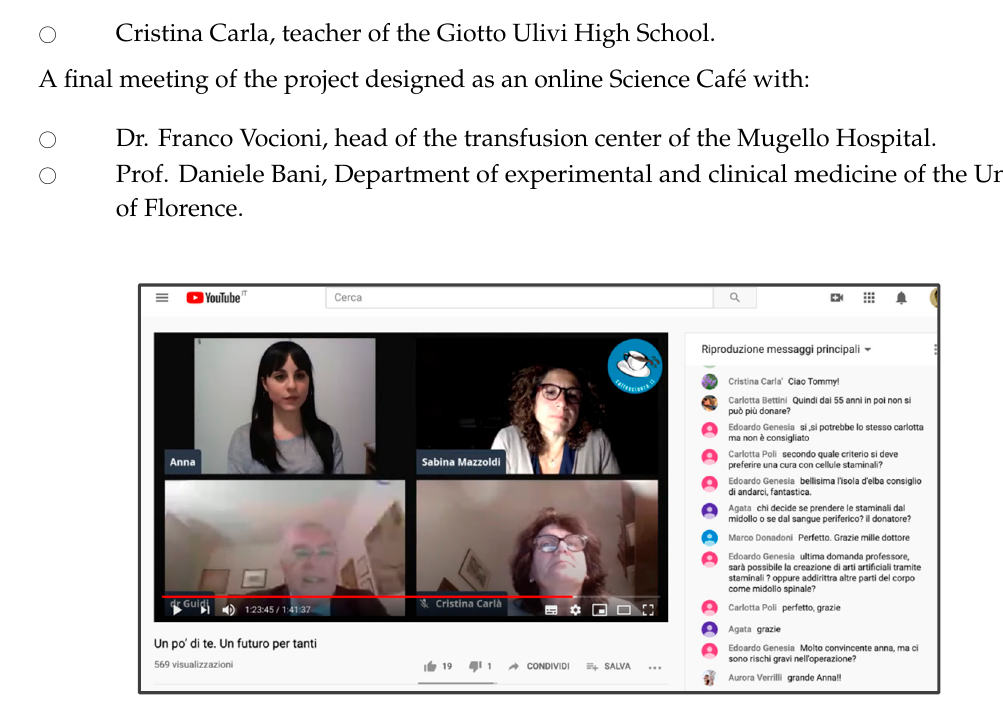
Figure 4. A moment of the Science Café demanded by the high school. Both events went well, with a large participation of students (more than 100 participants) who animated, with their questions and comments, the chat and the discussion (see, for instance, [27] with about 50 comments). The teachers were satisfied with the success in terms of numbers and